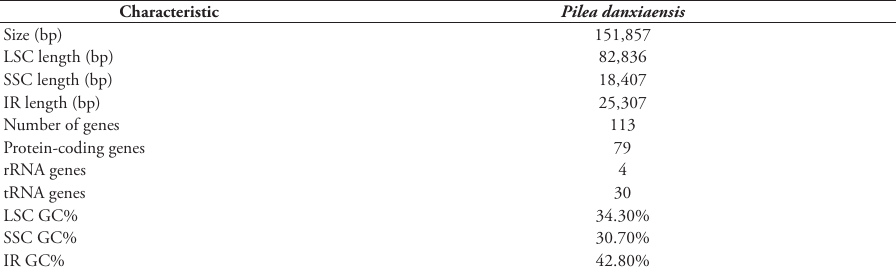
Table 1. Summary of whole plastid genome of Pilea danxiaensis .